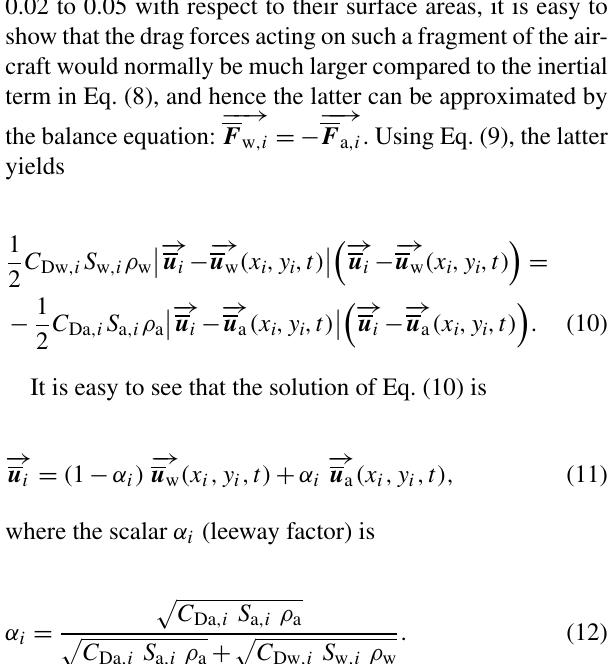
Figure 3. Assumed distribution of leeway factors across an ensem- ble (constant in time for an individual